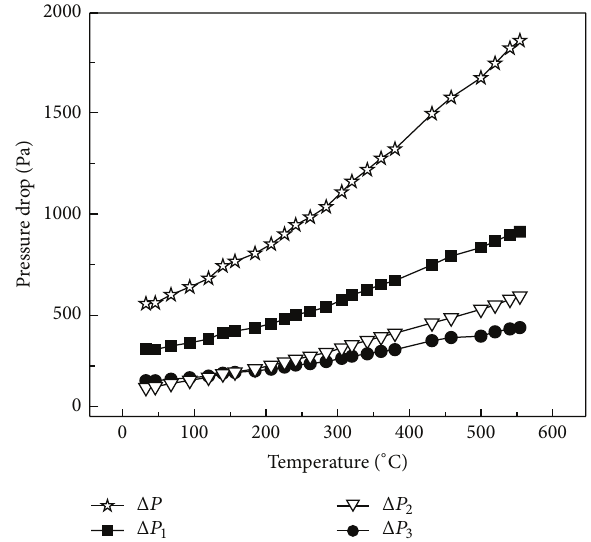
Figure 7: Pressure drop distribution with different catalytic oxida- tion bed average